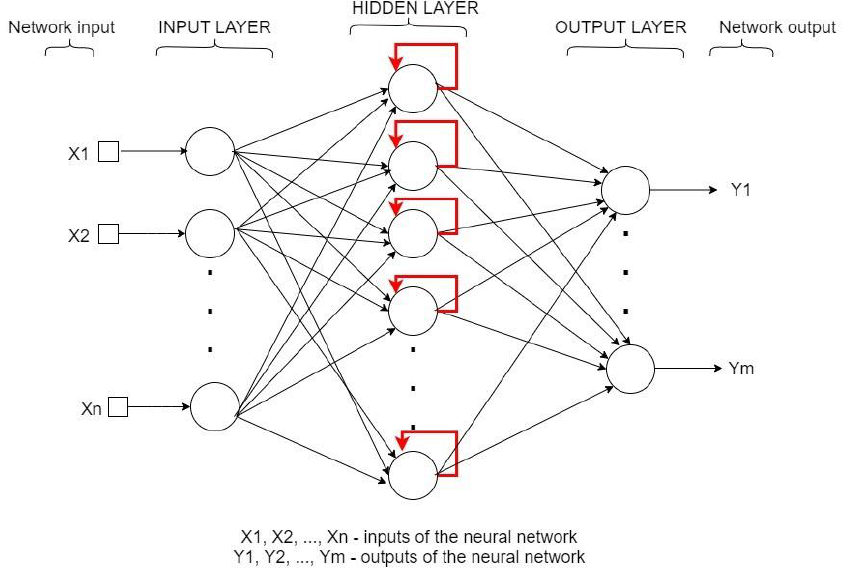
Figure 2. The architecture of a generic feed-back (recurrent) neural network with a single hidden layer .